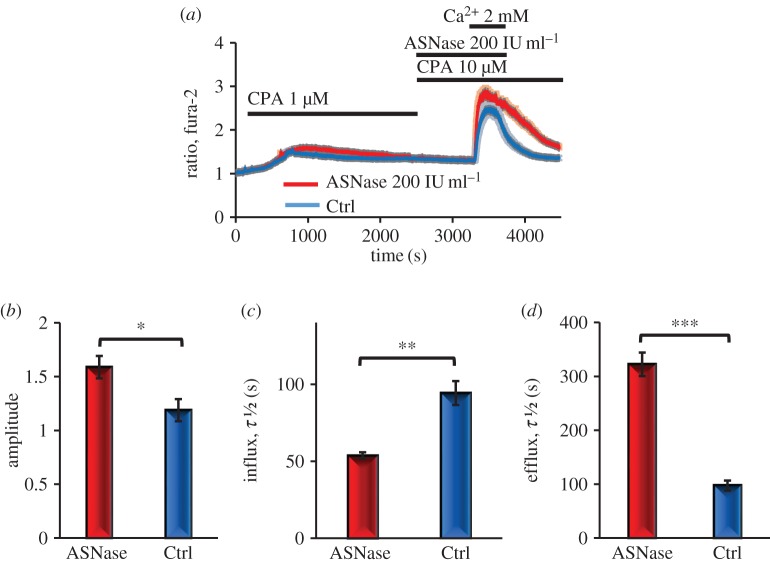
Asparaginase accelerates Ca2+ entry and substantially slows down Ca2+ extrusion. (a) In the absence of external Ca2+, CPA, a specific inhibitor of the Ca2+ pump in the ER membrane, causes a modest and largely transient [Ca2+]i rise. When subsequently 2 mM Ca2+ is added to the external solution, there is a marked rise in [Ca2+]i, which then declines after removal of external Ca2+. In the presence of asparaginase (red averaged trace, n = 32), the amplitude (b) and the rate of rise of [Ca2+]i (c) are somewhat increased (p < 0.048 and p < 0.0001, respectively) when compared with control (a, blue averaged trace, n = 34). The extrusion of Ca2+ by the plasma membrane Ca2+ pumps, observed as the decline in [Ca2+]i following removal of external Ca2+, is very markedly and significantly (p < 0.0001) reduced in the presence of asparaginase (a,d). (Online version in colour.)